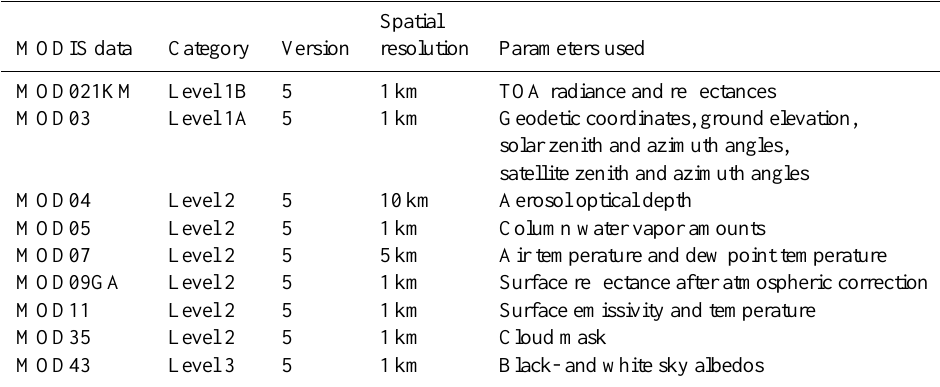
Table 1. MODIS data products used in this study and their characteristics as obtained from LAADS (Level 1 and Atmosphere Archive and Distribution Systems).